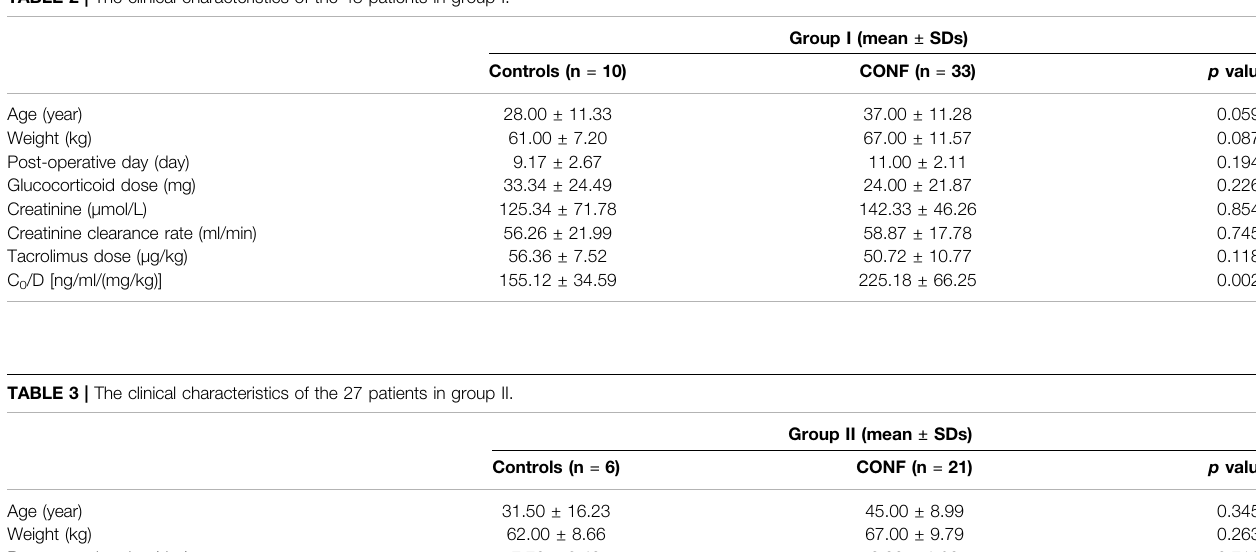
TABLE 2 | The clinical characteristics of the 43 patients in group I.